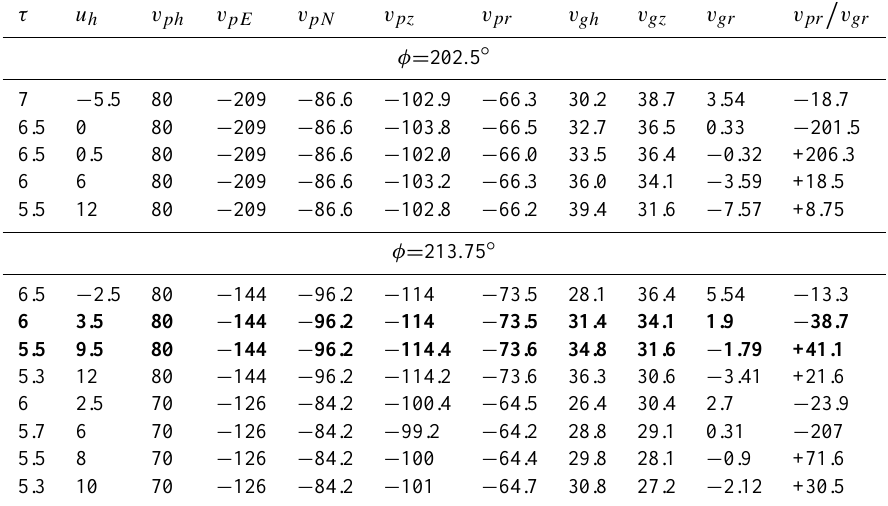
Table 3. Charateristic propagation velocities of gravity waves calculated from the dispersion relation with τ b = 5 . 0 min, H = 8km, v ph = 60 ∼ 100m/s and downward vertical phase propagation. The radar beam direction is defined by θ = 50 ◦ and φ is either 202 . 5 ◦ or 213 . 75 ◦ . These waves have their wave fronts parallel to magnetic field line ( v pz (cid:14) v pN = tan θ ∼= 1 . 19 ) . All the velocities are in m/s, and wave periods in minutes. τ u h v ph v